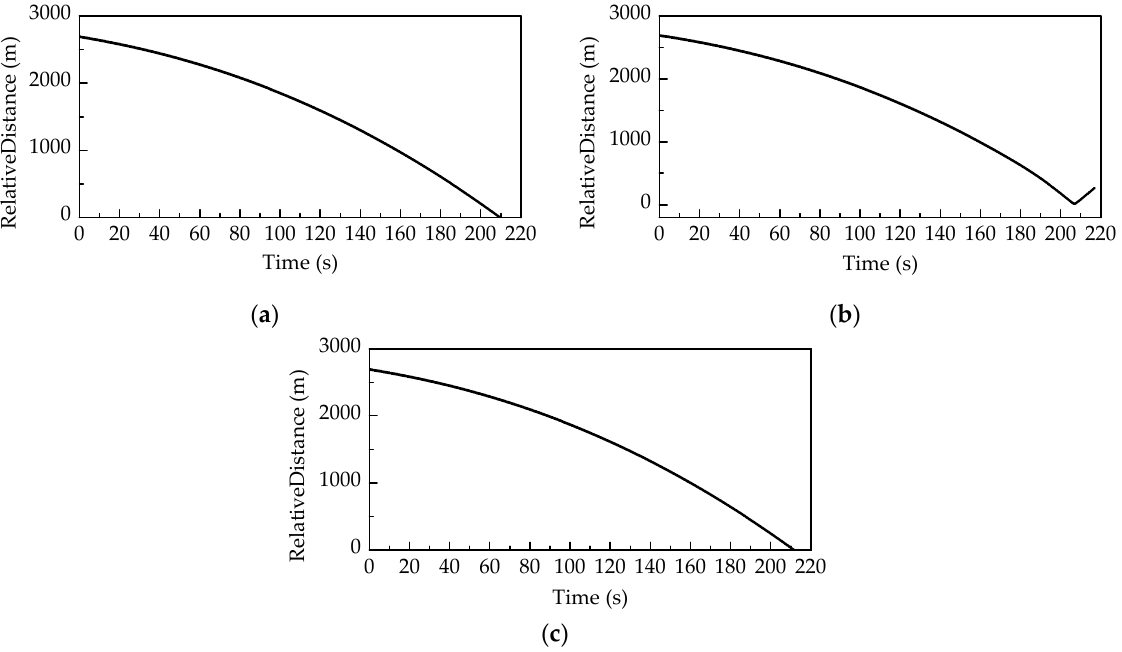
Figure 8. The average relative distance of 100 Monte Carlo runs in the scenario that the pursuer plays ( a ) without time delay; ( b ) without compensation for time delay; and ( c ) with compensation for time delay.